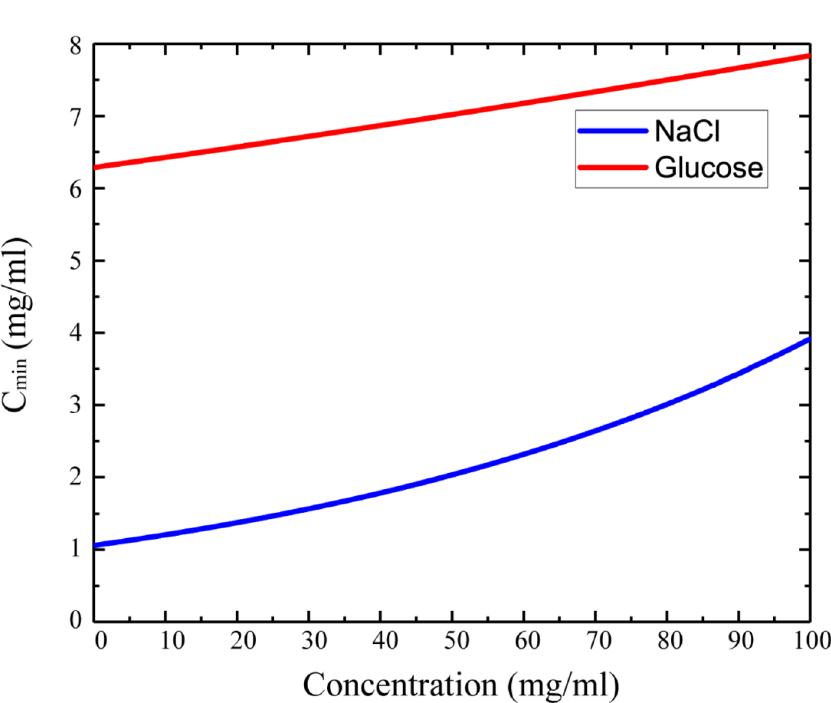
Figure 8. The calculated minimum detectable concentration as a function of NaCl (blue line) and glucose (red line) concentrations in aqueous